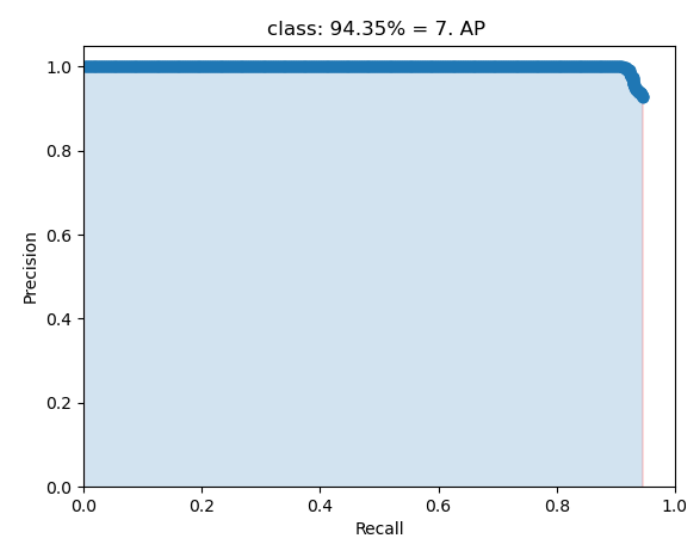
Figure 10. Precison-Recall curve of “7.”.